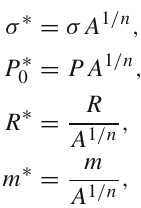
(dashed line) together with the corresponding k ( R ∗ (full line), while the associated Ω 2 curves are displayed in the lower panel. In all cases, the value of R ∗